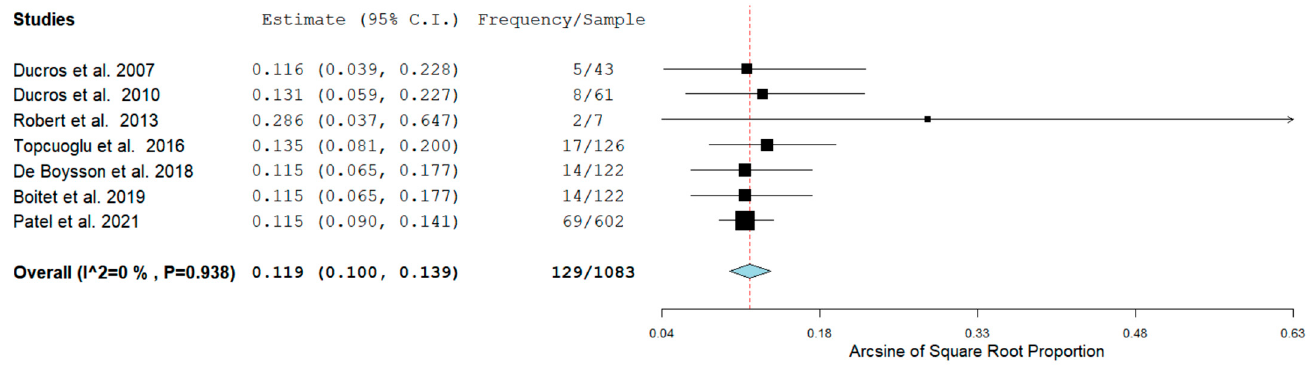
Figure 2. Pool Prevalence of RCVS in the postpartum period.